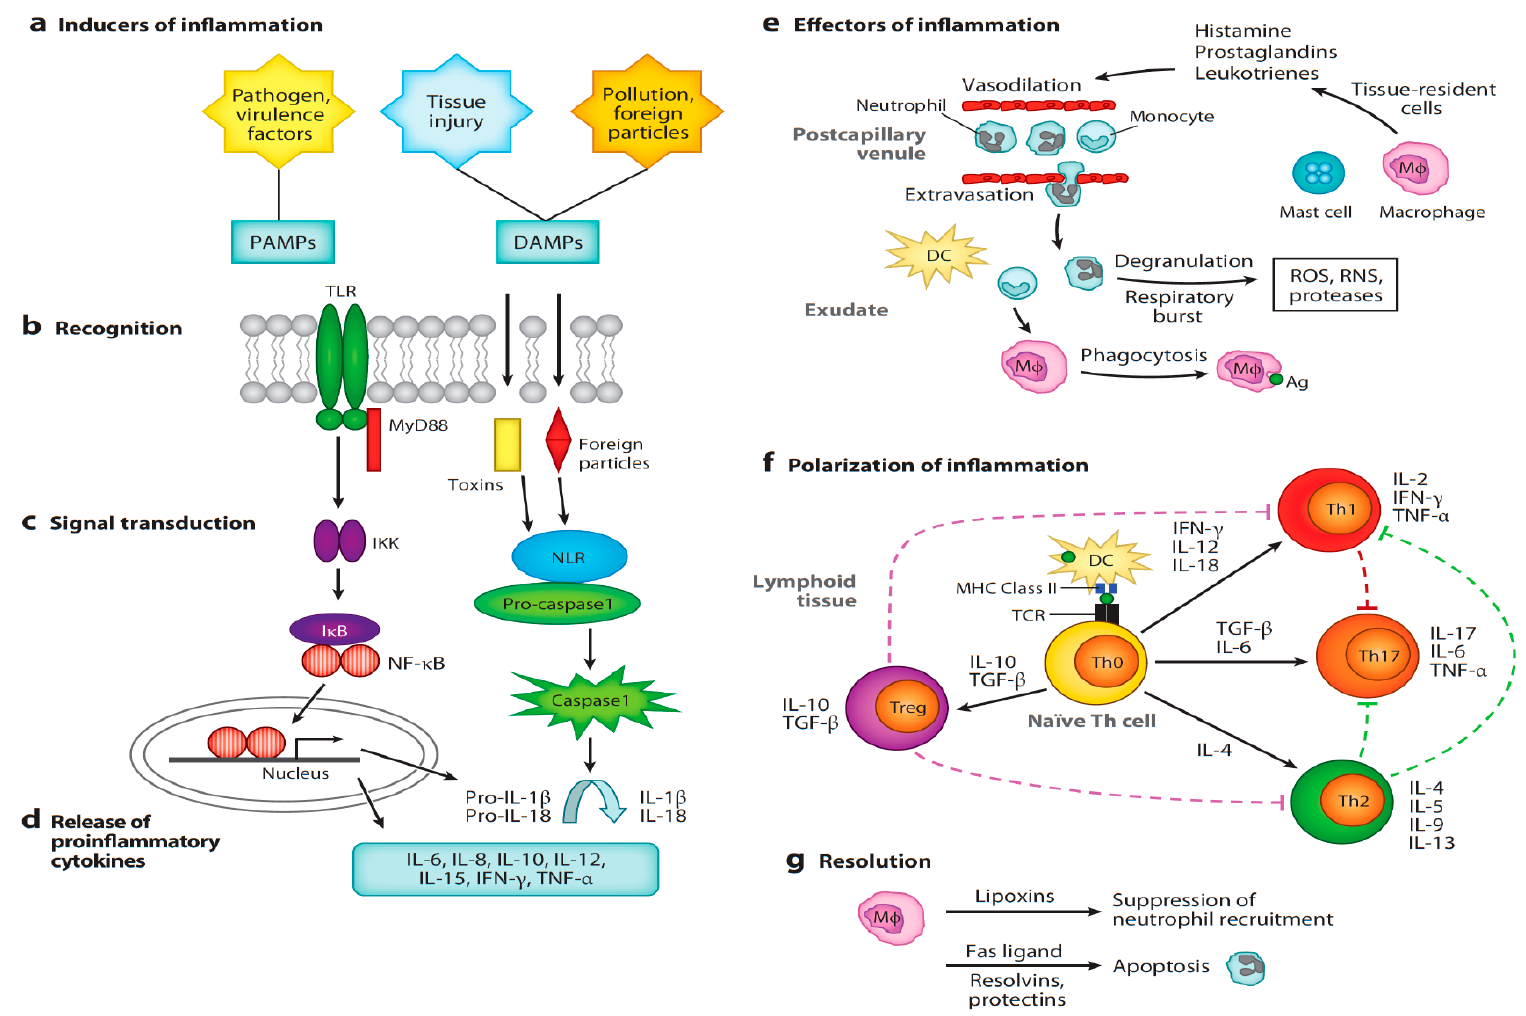
Figure 1. A primer of the inflammatory cascade. ( a ) Pathogens, tissue injury, and foreign particles induce inflammation. ( b ) Transmembrane TLRs and